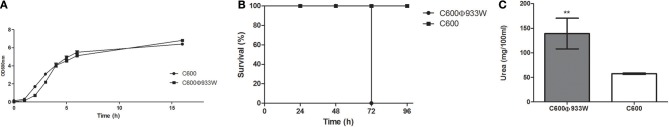
(A) Growth curves of E. coli C600 and E. coli C600Φ933W. Both strains present a similar growth curve with a non-significant difference between the viability counts. (B) Survival curve. Survival rates of mice infected with E. coli C600Φ933W are shown. Mice infected with E. coli C600 were used as controls. (C) Stx-induced renal damage. Plasmatic urea levels at 72 h post-infection were measured as a parameter of renal damage. Each bar represents the mean ± SEM of 4–6 mice/group. **P = 0.0095.